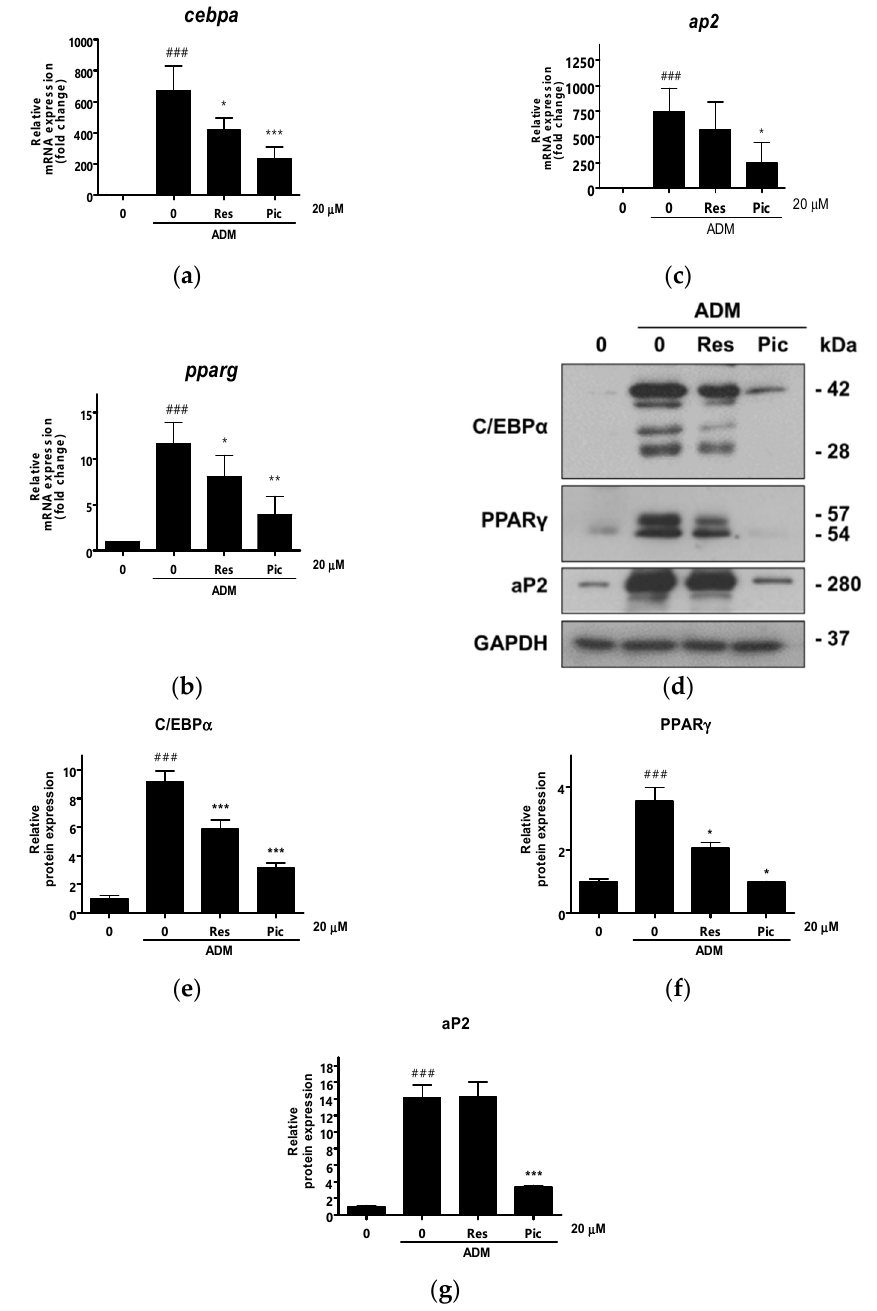
Figure 4. The effect of resveratrol (Res) and piceatannol (Pic) on the expression of adipogenic differentiation markers in human visceral adipose-derived stem cells (vASCs). ( a – c ) The relative mRNA expression of adipogenic genes, namely CCAAT/enhanced binding protein α (C/EBP α ), peroxisome proliferator-activated receptor γ (PPAR γ ), and adipocyte fatty acid binding protein (aP2), were analyzed using quantitative reverse transcription polymerase chain reaction (qRT-PCR) on day three after adipogenic differentiation medium (ADM) treatment. Data are expressed as means ± SD from three independent experiments ( ### p < 0.001 vs. undifferentiated group; * p < 0.05, ** p < 0.01, and *** p < 0.001 vs. ADM-treated group). ( d – g ) The protein expression of adipogenesis related proteins, namely CEBP/ α , PPAR γ , and aP2, were analyzed using Western blot on day four after ADM treatment. Data are expressed as means ± SD from three independent experiments (### p < 0.001 vs. undifferentiated group; * p < 0.05 and *** p < 0.001 vs. ADM treated